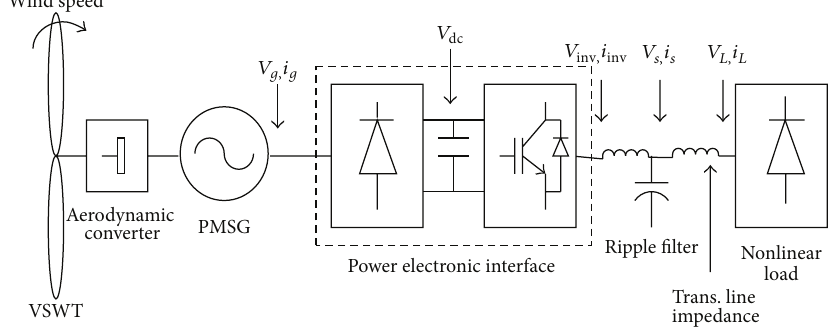
Figure 2: Power transfer stages in isolated WECS.